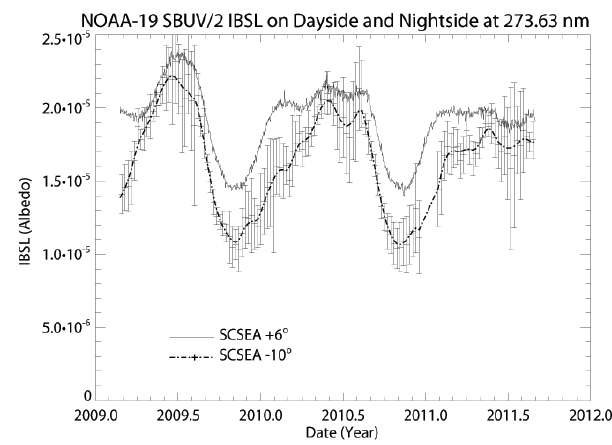
Fig. 6. N19 IBSL error values at 273nm at SCSEA =− 10 ◦ and SCSEA = 6 ◦ . At SCSEA =− 10 ◦ , the dayside weekly averages are derived from comparison of IPAR with N17. The noise (standard errors) in the weekly 0.5 ◦ latitude zonal means of the IPAR differ- ences propagated through the linear regression resulted in uncer- tainty in the estimated IBSL errors. Then, a piecewise linear fit is used to smooth and interpolate the weekly values. At SCSEA = 6 ◦ , N19 IBSL errors are derived directly from daily earth view mea- surements on the nightside (see Sect. 3.2), which have standard er- rors of around